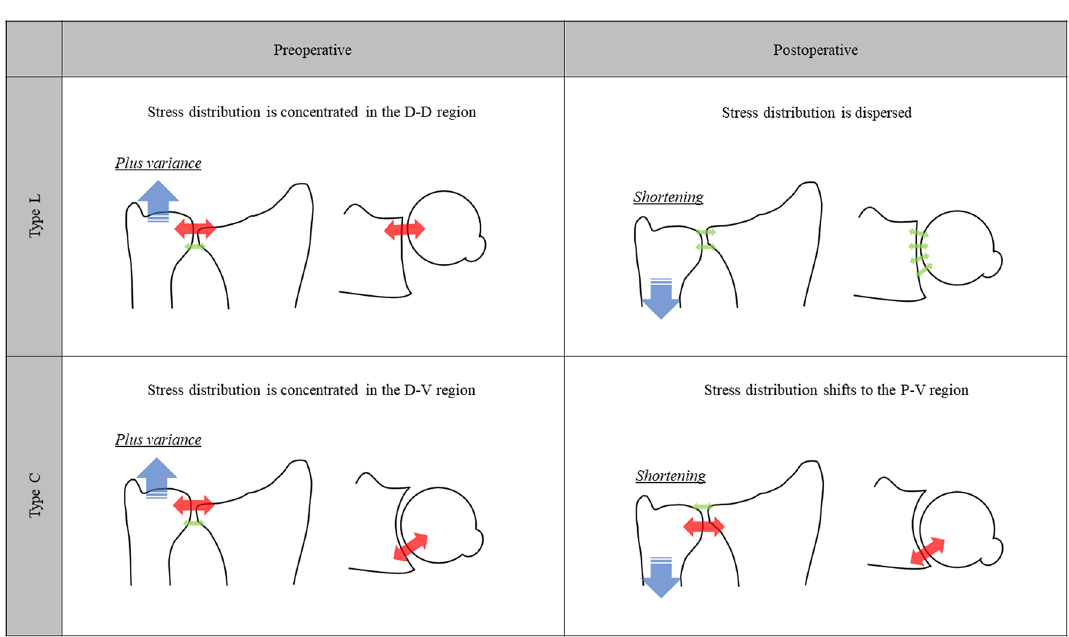
Figure 5. Mechanism of stress distribution in each bone morphological type of the sigmoid notch before and after surgery. D-V Distal-volar, D-D Distal-dorsal, P-V